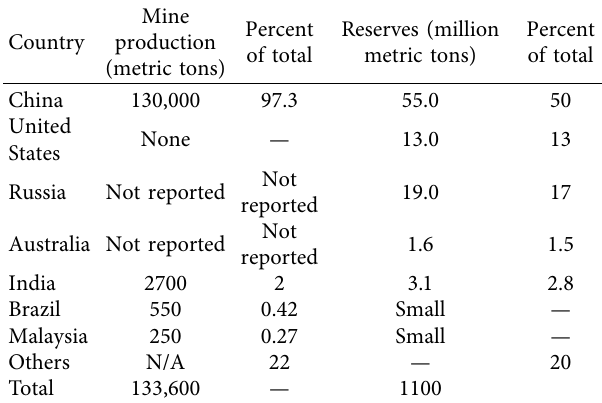
Figure 5: A comparison between the conventional vapour com- pression refrigeration (a) and magnetic refrigeration (b) [32]. Table 2: A summary of the world production and reserves of rare- earth elements in 2010 [4,